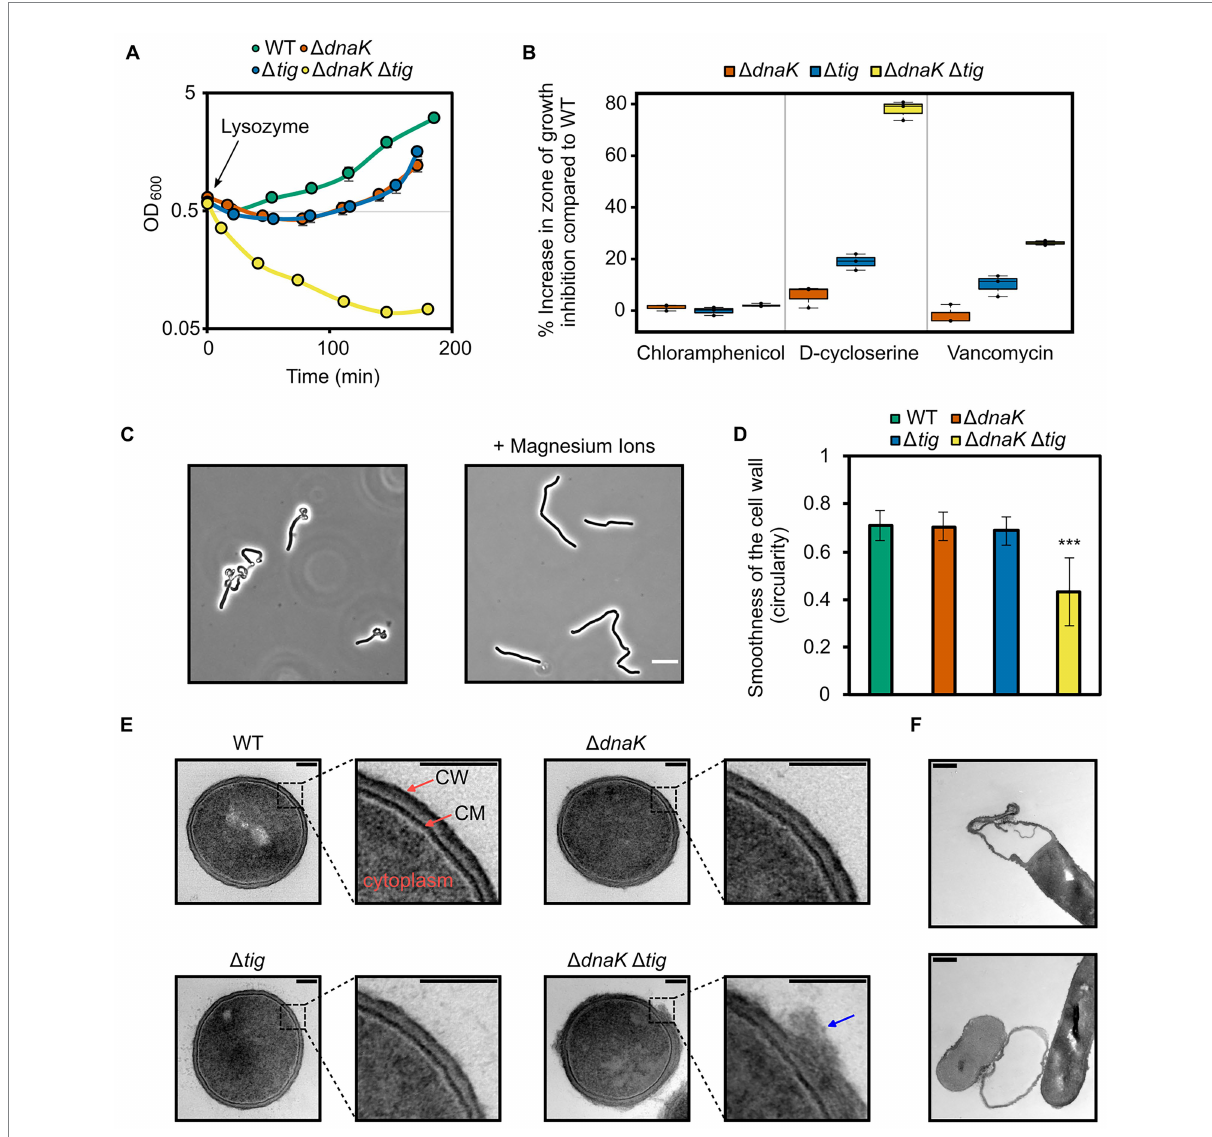
FIGURE 6 Effects of dnaK and tig deletions on cell wall integrity. (A) Cell density measured by OD at 600 nm of B. subtilis wild-type (1A1), Δ dnaK (LUW876), Δ tig (LUW901), and Δ dnaK Δ tig (LUW878) strains after the addition of 15 μ g/ml lysozyme at OD 600 = 0.6 ( t = 0). Strains were grown in NSMPG at 30 ° C. Each strain was grown in triplicates, and error bars represent the standard deviation between them. Error bars might not be seen due to the small variation. (B) Sensitivity of the indicated strains to chloramphenicol (protein synthesis inhibitor), D-cycloserine and vancomycin (antibiotics targeting the cell wall). Plotted is the increase in percentage in the zone of growth inhibition when compared to the wild-type strain. Three antibiotic discs were used for each strain, and error bars display the standard deviation between the triplicates. Plates with antibiotic discs were incubated at 30 ° C for 20 h. (C) Representative phase contrast micrographs of Δ dnaK Δ tig cells from overnight TBAB plates without (left image) or supplemented with 25 mM MgSO 4 (right image). Plates were incubated at 30 ° C. Scale bar represents 10 μ m. (D) Smoothness of the cell wall of the four indicated strains. Smoothness was determined by measuring circularity values of the cell wall outlines in Fiji (Schindelin et al., 2012). TEM transversal sections from 10 cells (as the ones shown in “E”) were analyzed per each strain. Error bars display the standard deviations for the triplicates. The values were subjected to a two-tailed heteroscedastic t-test, comparing each strain with the wild-type (1A1). Significant differences are denoted by asterisks (***: value of p < 0.001). (E) Representative TEM transversal sections of the indicated strains. Cells were grown until exponential phase in a liquid broth medium (NSMPG) at 30 ° C. Scale bars represent 100 nm. “CM”: cytoplasmic membrane; “CW”: cell wall. Blue arrow indicates cell wall material that appeared loose from the surface. (F) TEM longitudinal sections showing Δ dnaK Δ tig (LUW878) “empty” cells. Scale bars represent 100 nm.